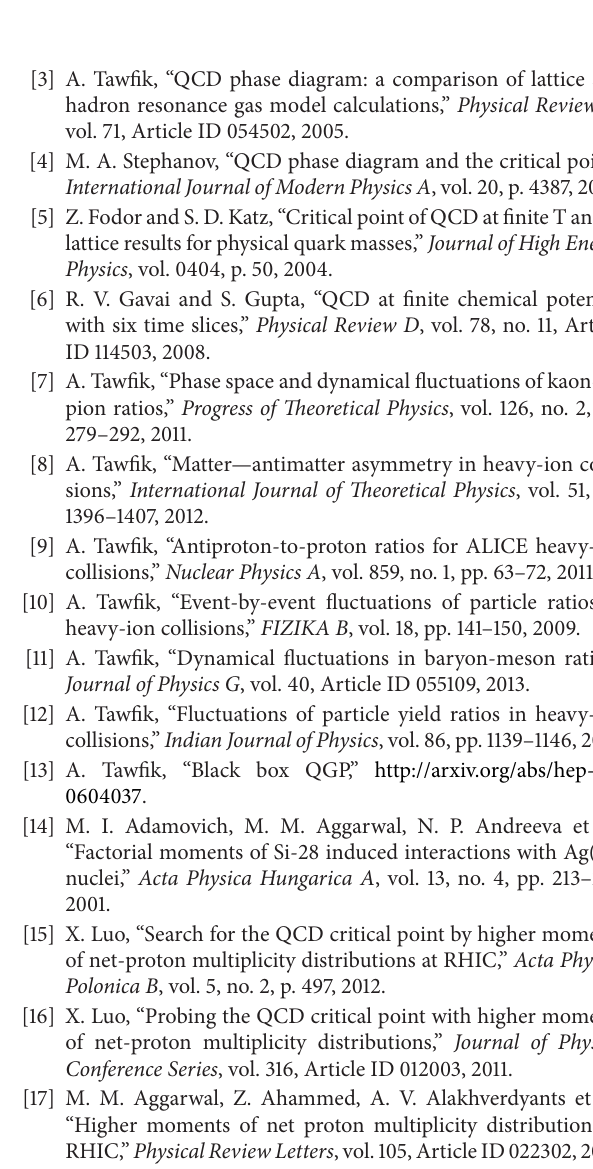
Figure 15: Left panel: Skewness and kurtosis at the freeze-out boundary for fermions and bosons. The curves of both quantities are crossing at almost the same 𝜇 -value. The corresponding 𝑇 -values are almost equal.